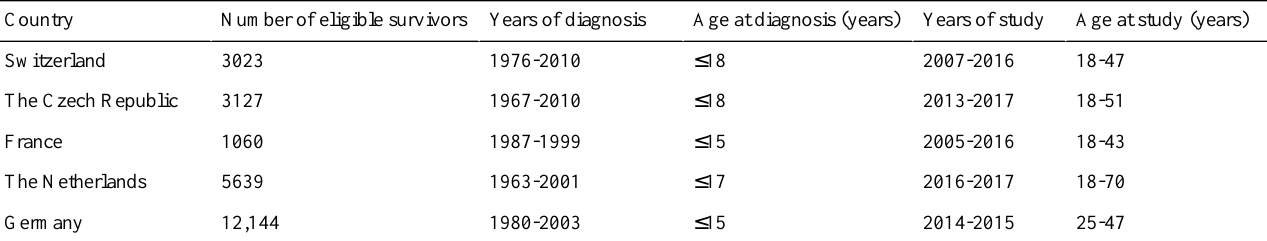
Table 2. Number of eligible patients, time period of cancer diagnosis, age of survivors at diagnosis, time period of the health-related quality of life (HRQoL) survey, and age of survivors at HRQoL survey, by